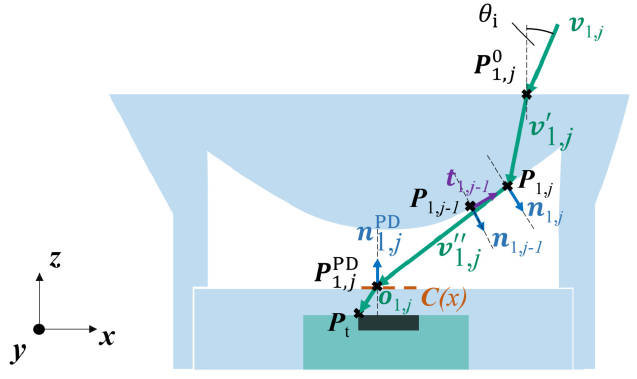
Figure 2. Geometrical construction of the lens surface.